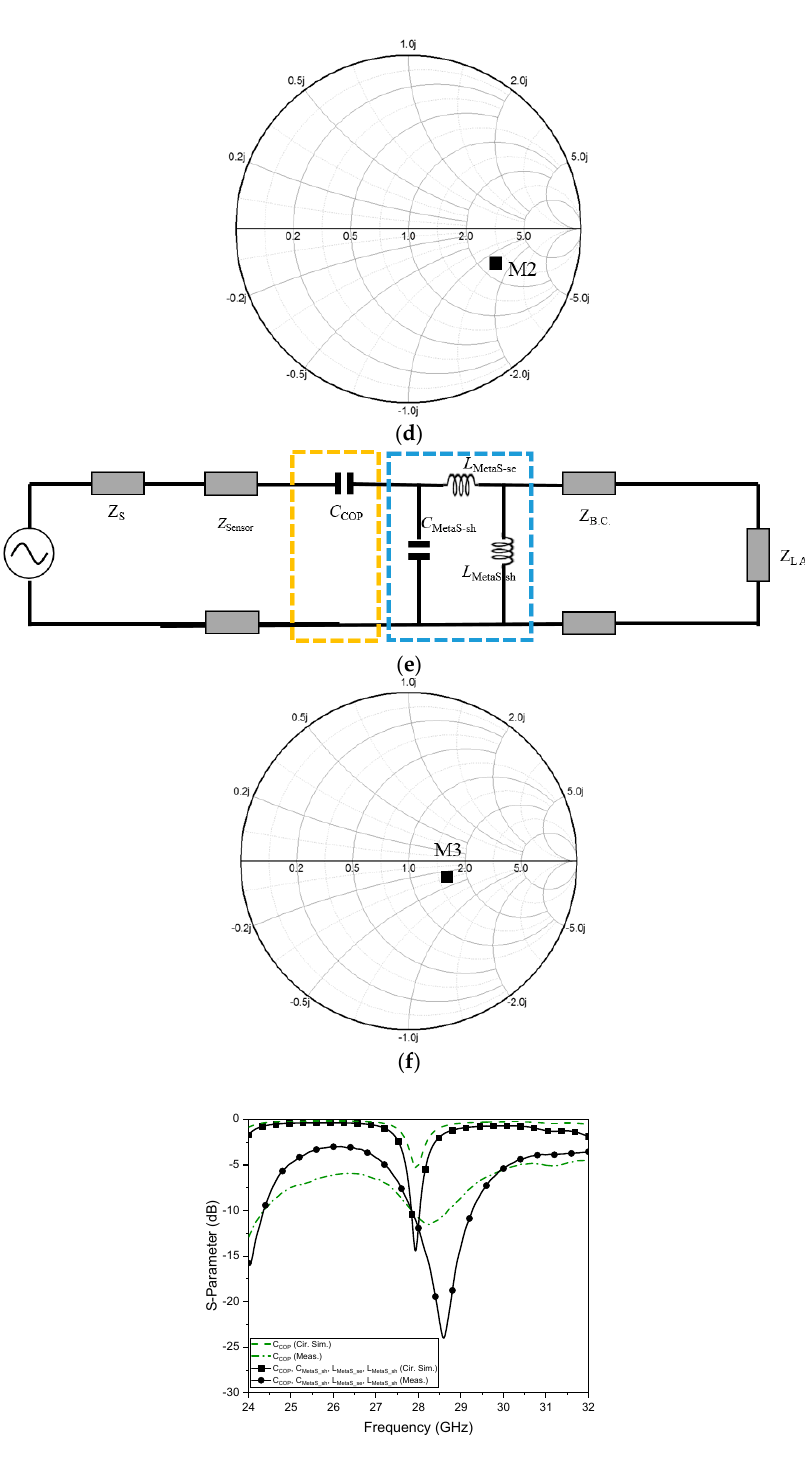
Figure 10. Electromagnetic-field and electrical circuit modelling points of view on the novel MUT sensor. ( a ) EM field of the array sensor alone is degraded by the back-cover and COP-film. ( b ) EM field becomes normal by the impedance matching via the meta-surface. ( c ) Electrical circuit model of the effects of the COP film. ( d ) Impedance of the capacitive effect of COP film. ( e ) Circuit model of the COP-film, meta-surface and back-cover together. ( f ) Impedance of the additional circuit block as the COP film meta-surface. ( g ) Comparing s-parameters of the circuit model analyses and the corresponding